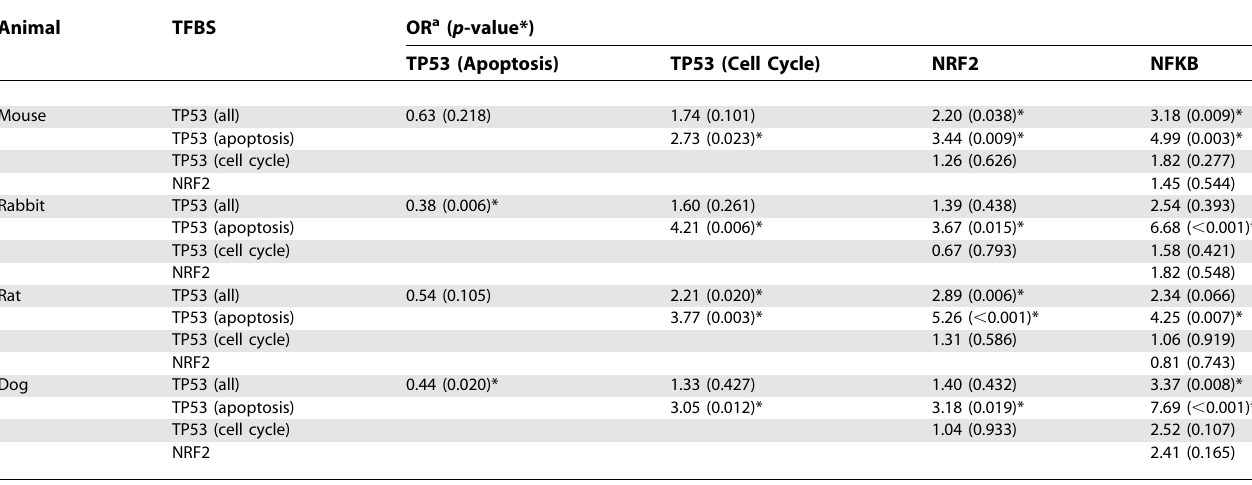
Table 4. Comparison of Mean TFBS Conservation Values (Mouse to Human, Rabbit to Human, Rat to Human, and Dog to Human) Animal